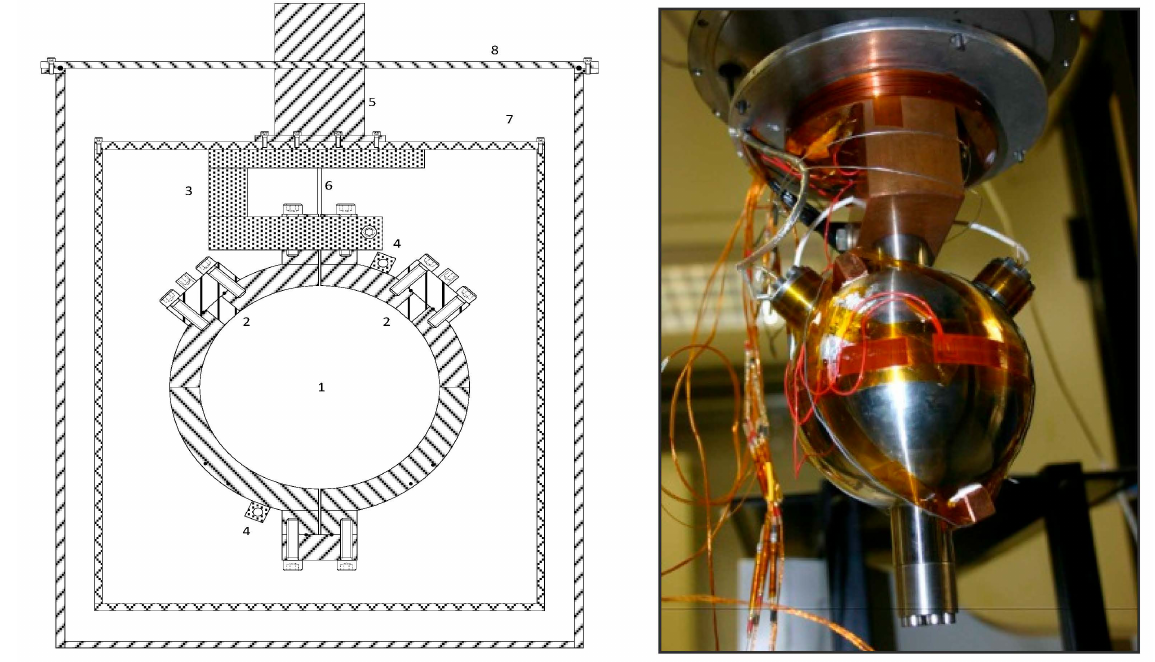
Figure 1. A schematic view of the spherical resonator [18]: 1, spherical cavity; 2, acoustic transducers; 3, copper block where the sphere is suspended; 4, thermoresistance holders; 5, main structure; 6, inlet/outlet pipe; 7, thermostatic vessel; 8, vacuum vessel. On the right is a picture of the